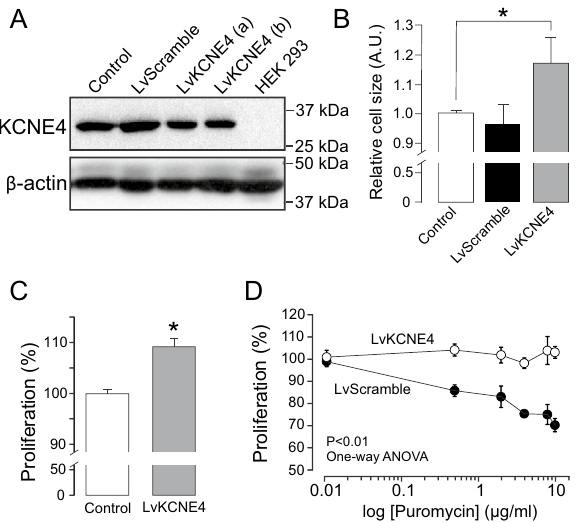
Figure 5. KCNE4 depletion alters CY15 dendritic cell size and proliferation. CY15 cells were treated with shRNA lentiviral particles against KCNE4, and FBS-dependent proliferation was analyzed. ( A ) Representative western blot of KCNE4 protein expression in control CY15 dendritic cells treated with LvKCNE4 and LvScramble particles. HEK 293 cells were used as a negative control. β-actin was used as a loading control. Results from two independent clones (a and b) are shown. ( B ) Relative cell size of control CY15 dendritic cells (white bars), LvScramble (black bars) and LvKCNE4 (gray bars) cells. Control size was 10.4 ± 0.3 µm